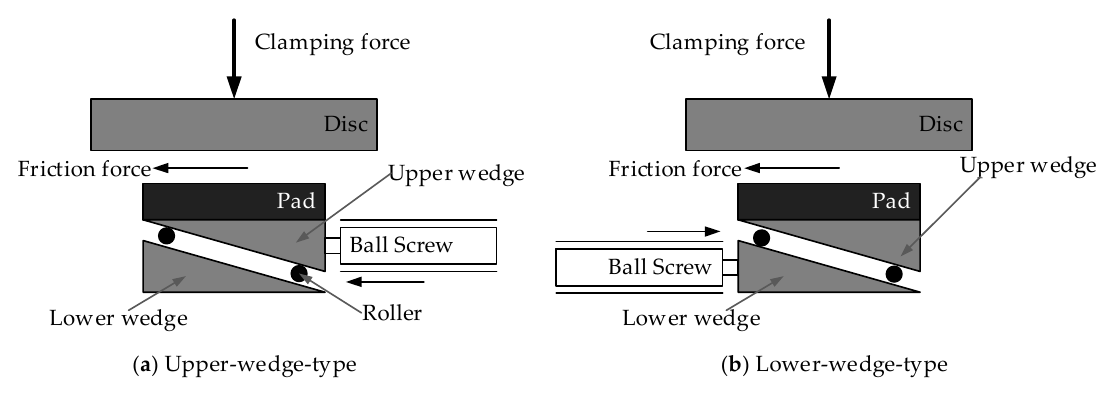
Figure 6. Upper-wedge electro-wedge brake ( EWB) and lower-wedge EWB.